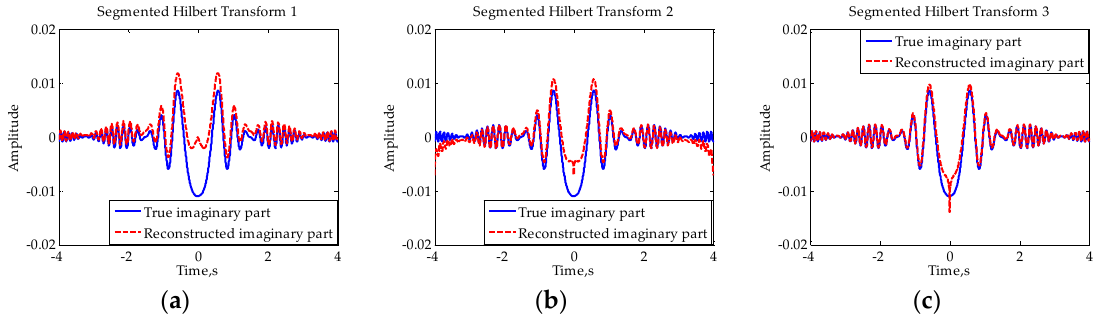
Figure 5. Comparisons of the results of different segmented Hilbert transforms: ( a ) Approach 1; ( b ) Approach 2; ( c ) Approach 3.